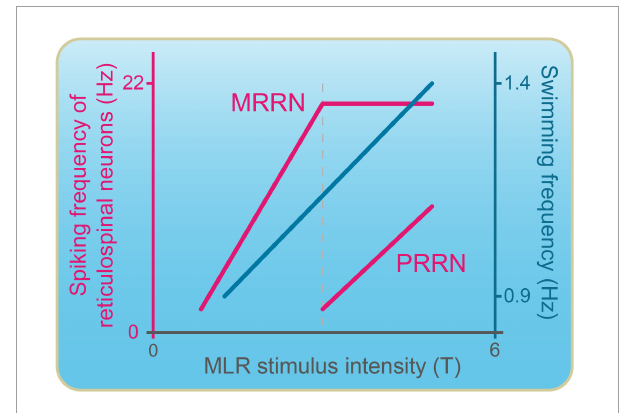
FIGURE5 Recruitment pattern of reticulospinal neurons as the stimulation in the MLR is increased. The spiking frequency of reticulospinal neurons and swimming frequency are plotted against the intensity of MLR stimulation. Reticulospinal neurons in the pons (MRRN) are recruited at low MLR intensity and rapidly reach a discharge frequency plateau. Bulbar reticulospinal neurons (PRRN) are recruited at higher MLR stimulation intensities. They start discharging when the discharge frequency of pontine reticulospinal cells has reached a plateau. Adapted from Brocard and Dubuc